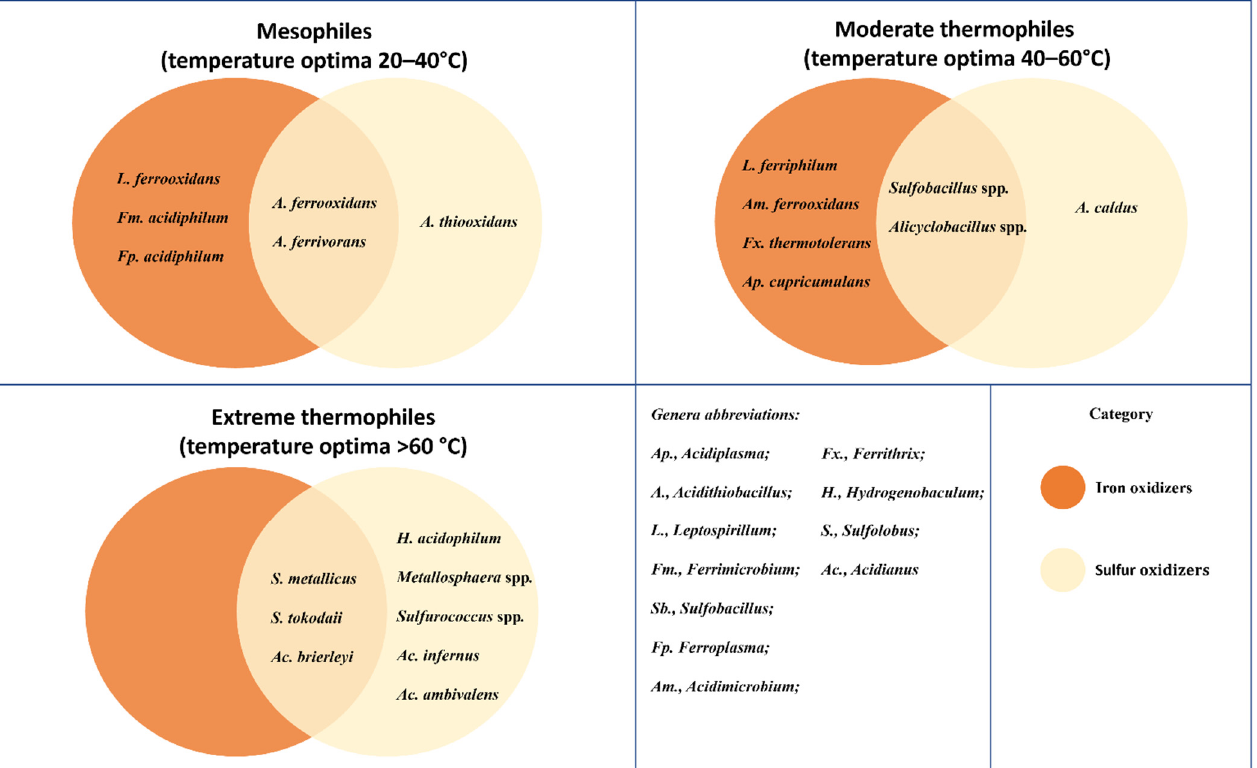
Figure 2. Acidophilic iron and sulfur-oxidizing microorganisms classified based on growth temperature optima. Adapted with permission from Johnson [28], published by Springer Netherlands, 2010.